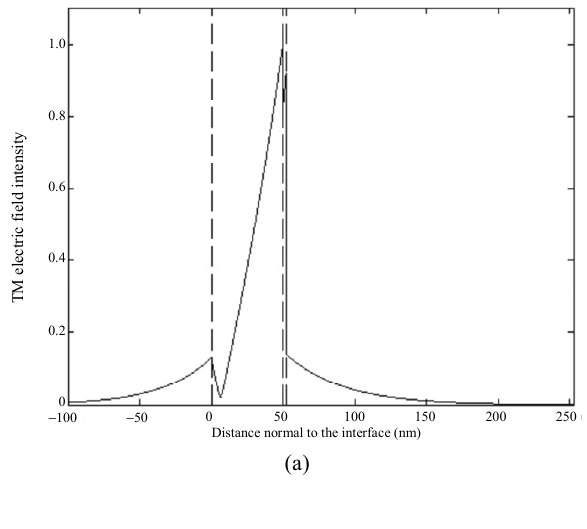
Fig. 7 TM field intensity as a function of distance normal to the interface at the sensing layer refractive index of 1.33, for the SPR sensors based: (a) structure-I, (b) structure-II, and (c)